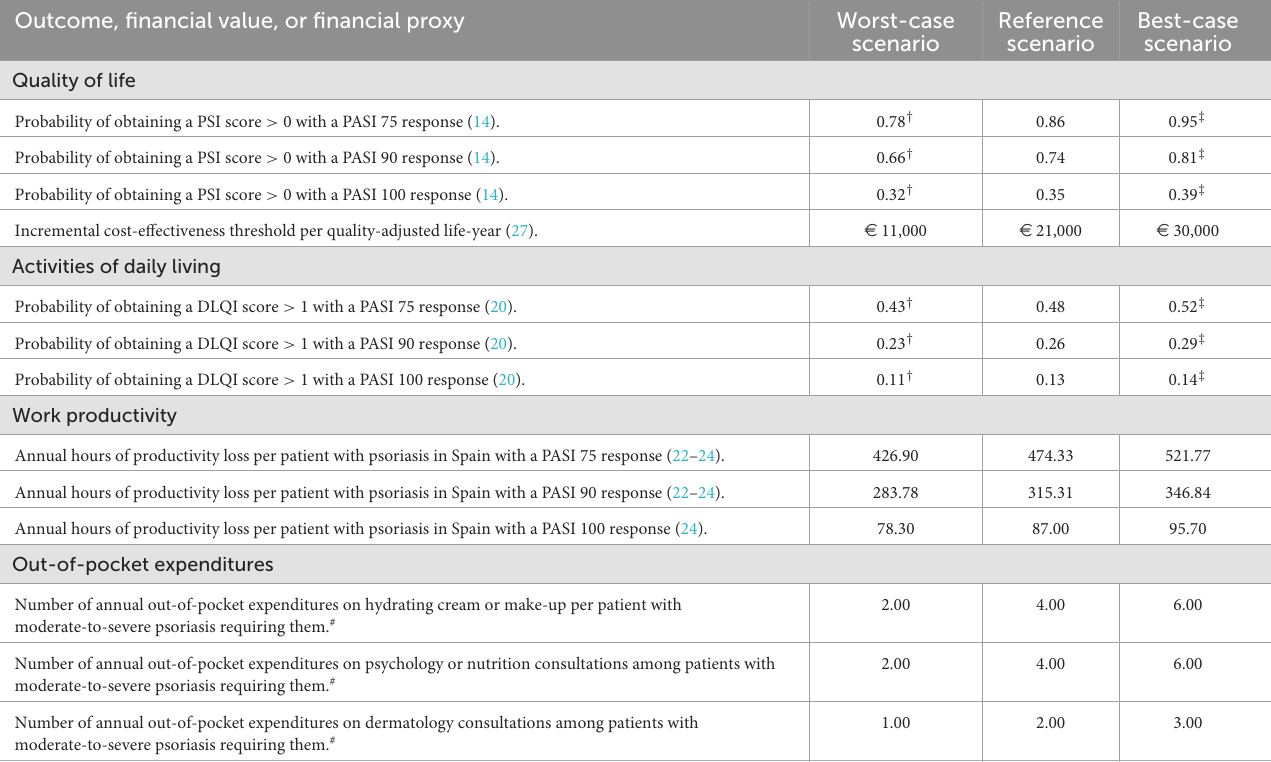
TABLE 3 Outcomes, financial values, or financial proxies included in the sensitivity analysis. Outcome, financial value, or financial